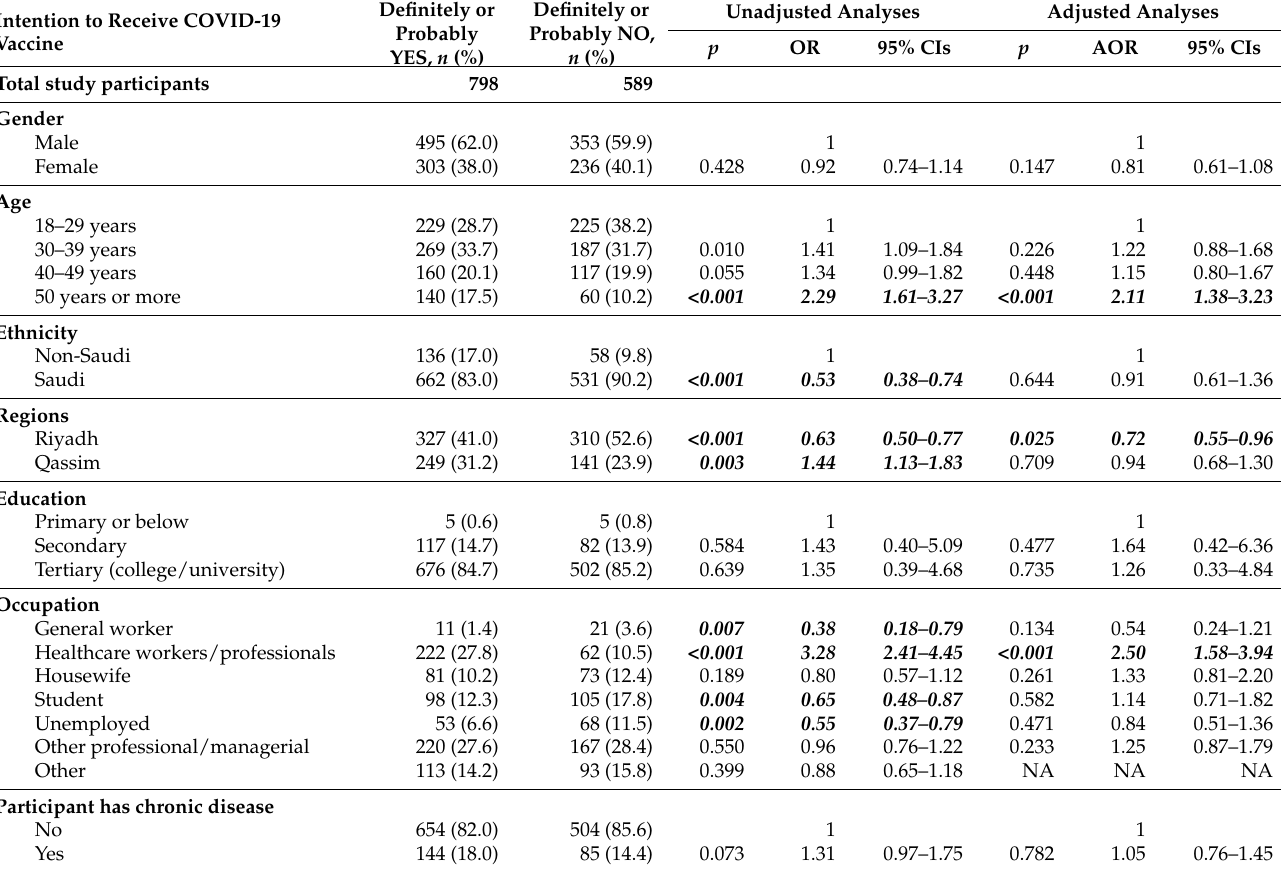
Table 3. Factors associated with intention to receive a COVID-19 vaccine in KSA, February–March